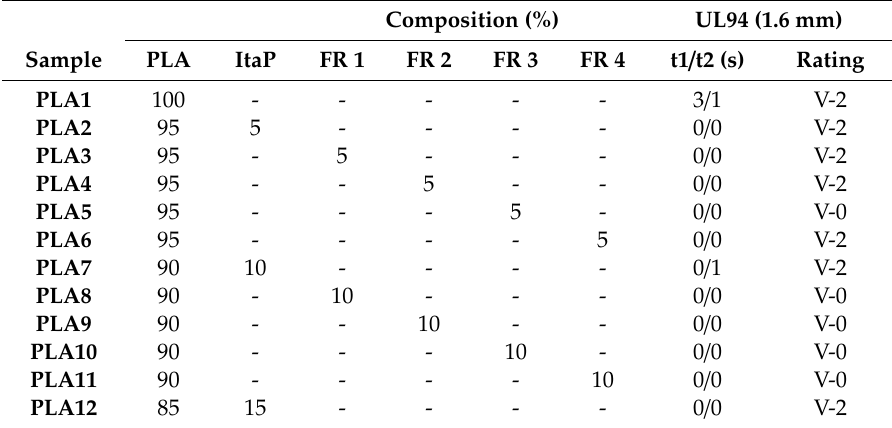
Table 3. UL94 classification of the PLA composites with low viscosity.